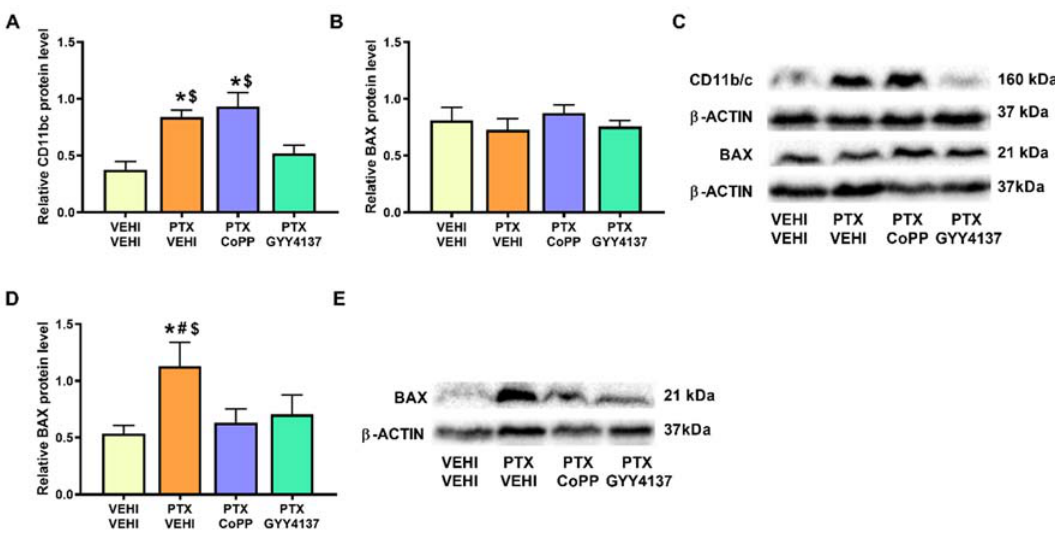
Figure 10. Effects of CoPP and GYY4137 treatments on the expression of CD11b/c in the PFC and BAX in the PFC and DRG of PTX-injected mice. Graphs represent the expression of CD11b/c in PFC ( A ), and BAX in the PFC ( B ) and DRG ( D ) of PTX-injected mice treated with CoPP or GYY4137. Animals treated with VEHI–VEHI were used as controls. Representative blots for CD11b/c and BAX ( C ) in the PFC and for BAX in the DRG ( E ) are shown. All proteins are represented relative to β -actin levels. In all panels, * indicates significant differences vs. the VEHI–VEHI-treated animals; #, vs. the PTX–CoPP-treated animals; and $, vs. PTX-injected mice treated with GYY4137 ( p < 0.05, one-way ANOVA followed by the SNK post hoc test). Data are expressed as mean values ± SEM; n = 3 samples per group.